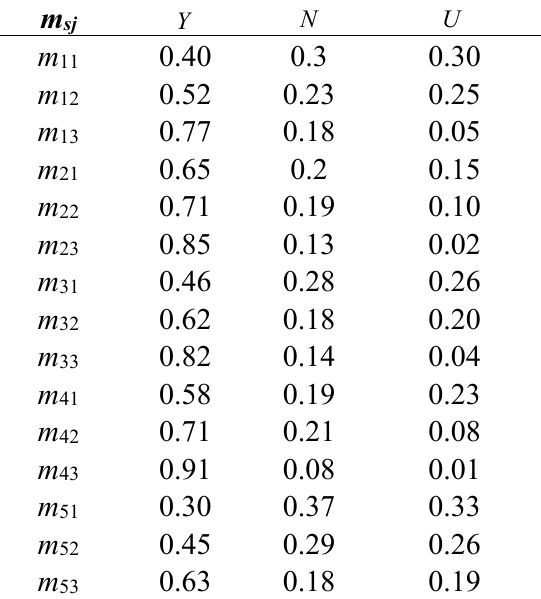
Table 7. Basic probability values of all sensors during three time periods.